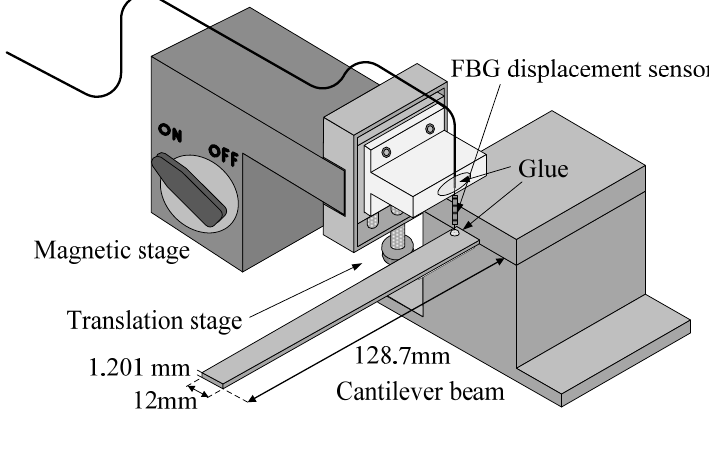
Figure 1. Illustration for the set-up method for the displacement FBG